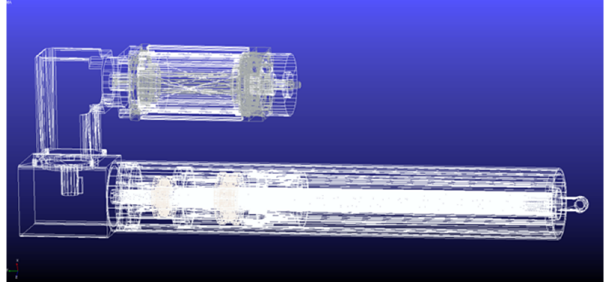
Figure 3. ADAMS model of multistage EMA